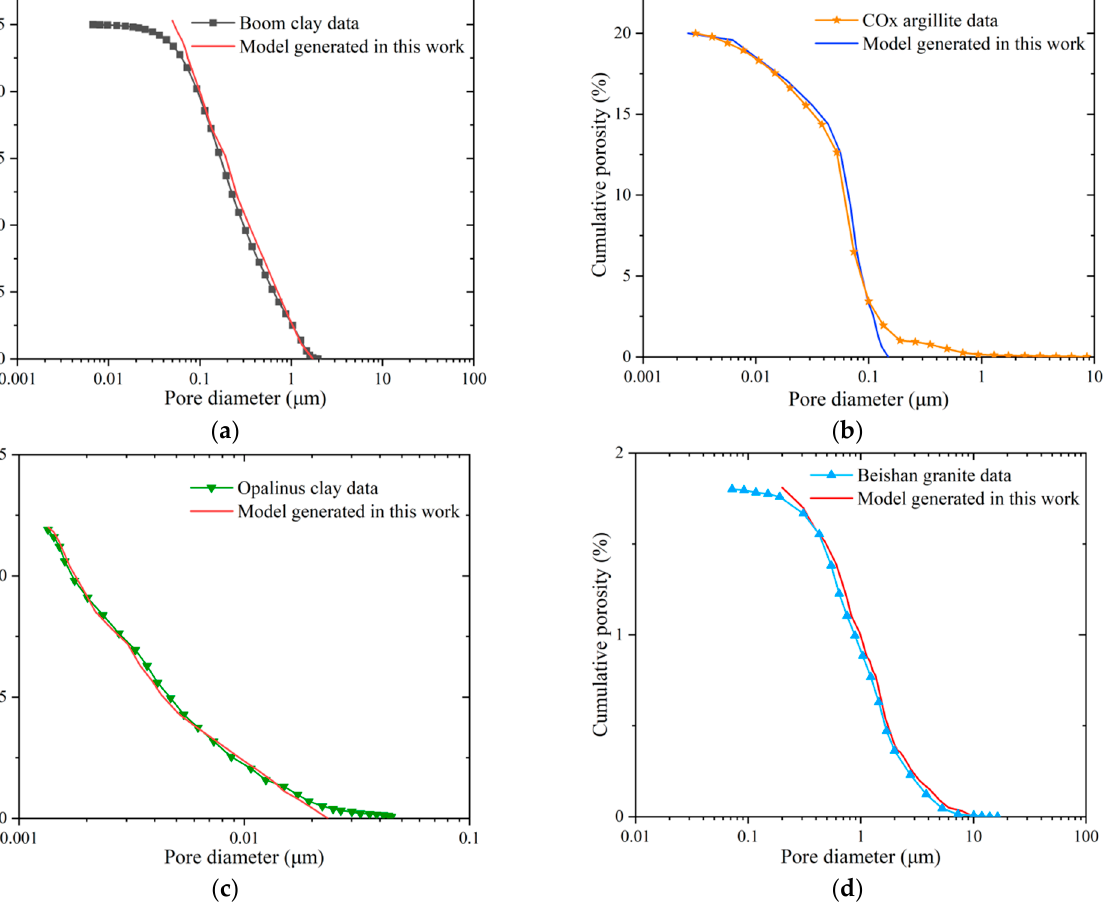
Figure 11. PSDs of the generated models. ( a ) Boom clay; ( b ) COx argillite; ( c ) Opalinus clay; ( d ) Beishan granite.